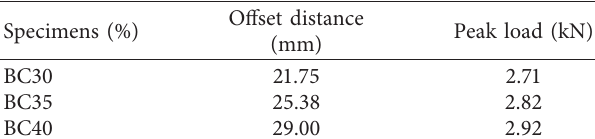
Figure 2: P-CMOD curves for the specimens with one single offset notch. (a) Offset rates 0%. (b) Offset rates 10%. (c) Offset rates 20%. (d) Offset rates 30%. (e) Offset rates 40%. (f) Offset rates 50%. Table 2: Peak loads for the specimens with central and offset double notches.